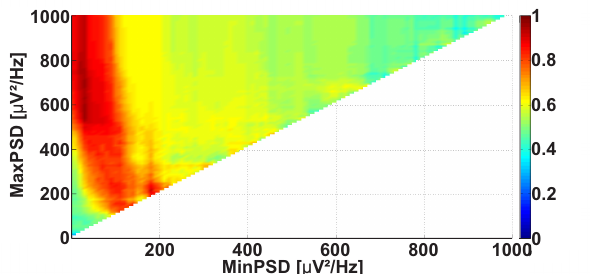
Figure 12. An example of the Power spectral density AUC diagram. The frequency band of the wave trains is constrained, and the frequency interval from 8 to 20 Hz is considered. The abscissa axis indicates the lower bound of the PSD range; the ordinate axis indicates the upper bound of the PSD range. A bright red area is observed along the ordinate axis; the x-coordinate is equal to approximately 30 µ V 2 / Hz. The brightest point has the following coordinates: 30 µ V 2 / Hz and 700 µ V 2 / Hz. This point corresponds to the PSD range from 30 to 700 µ V 2 / Hz.